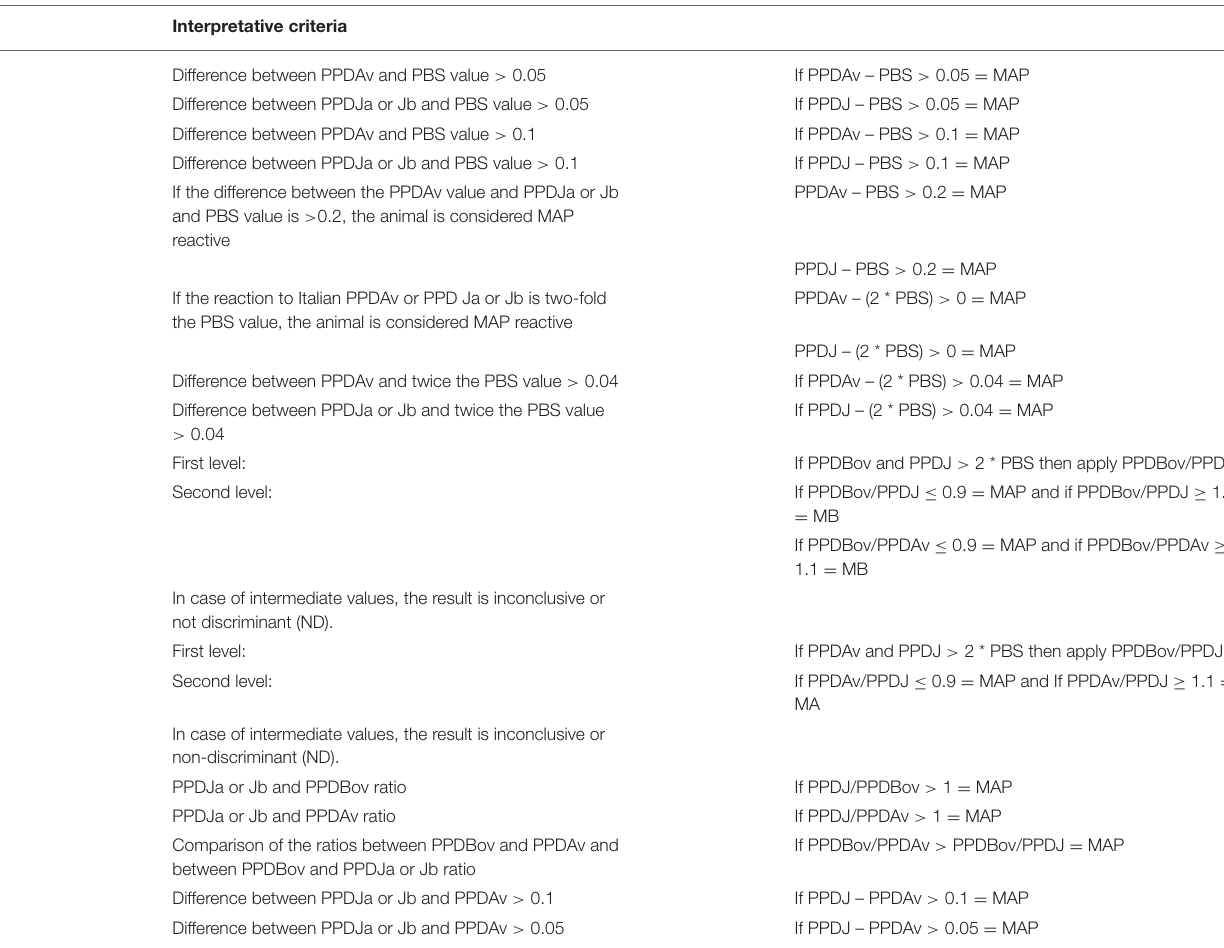
TABLE 1 | Interpretative criteria of the IFN- γ test and cutoff values applied in the study for the diagnosis of Mycobacterium avium subsp. paratuberculosis (MAP) infected cattle. Interpretative